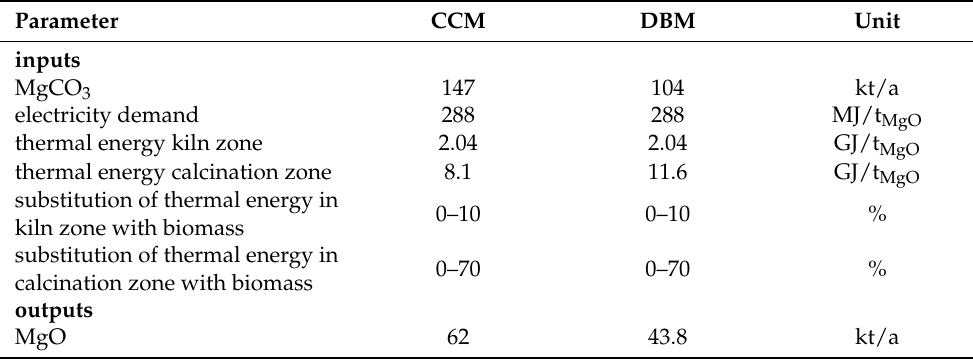
Table 2. Main LCI parameters of MgO production plant [33].